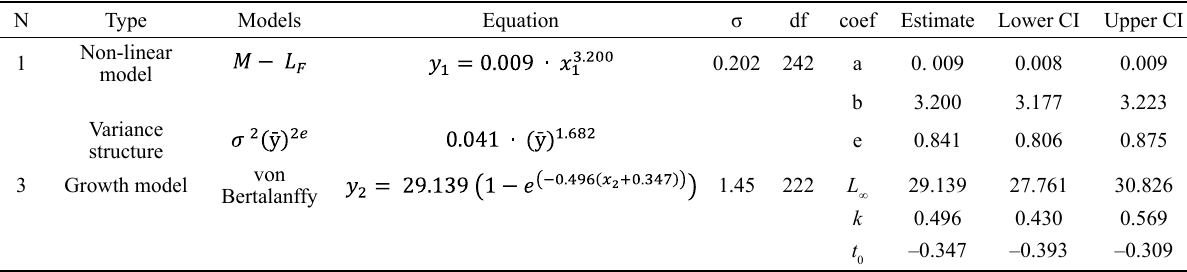
(1) best variance structure and non-linear growth model (2). Equation F ( x ), mean growth curve ( ӯ 2